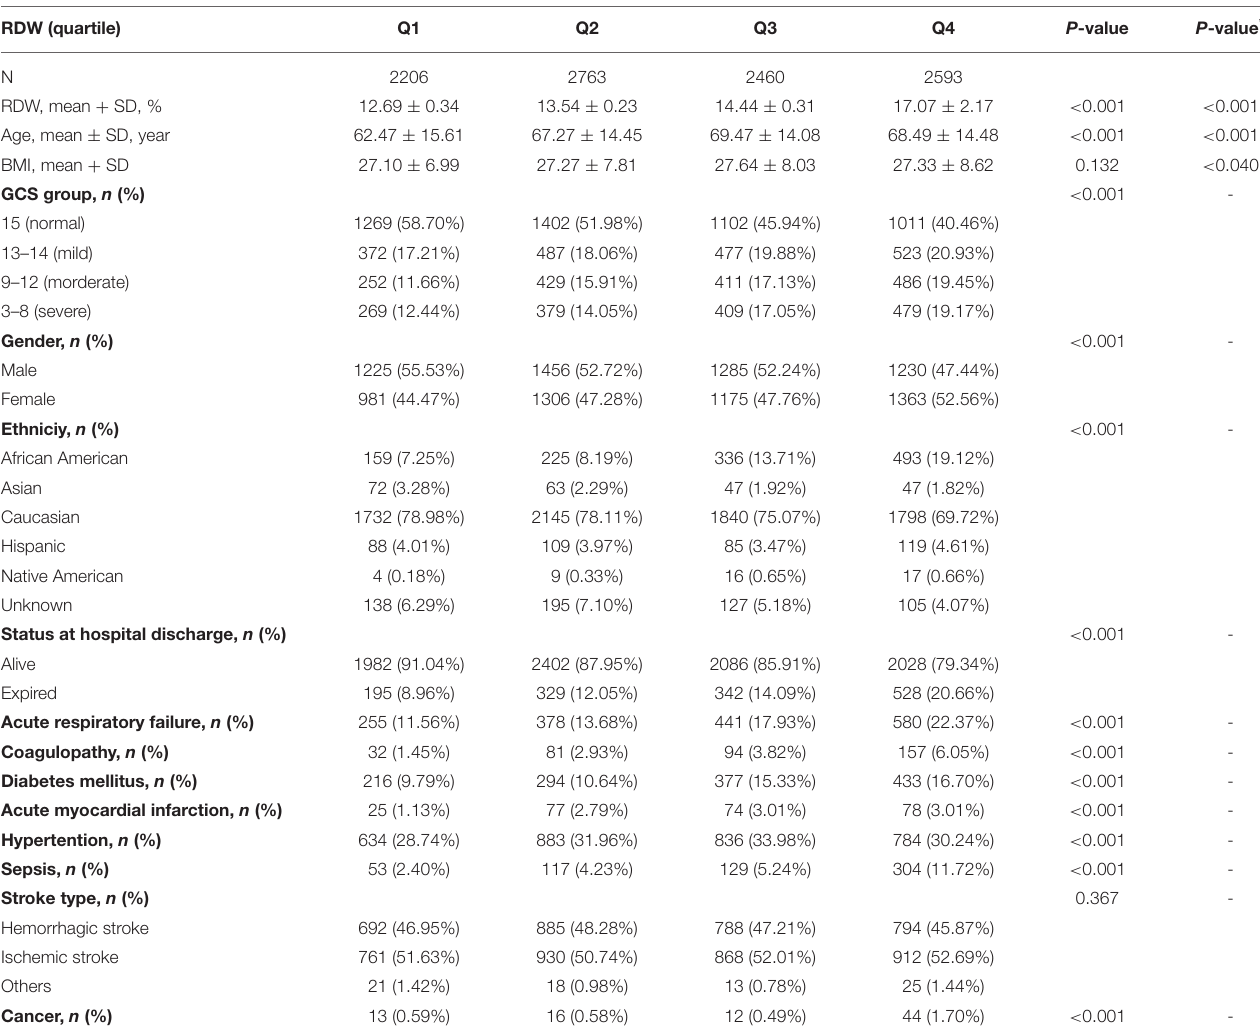
TABLE 1 | Baseline characteristics of